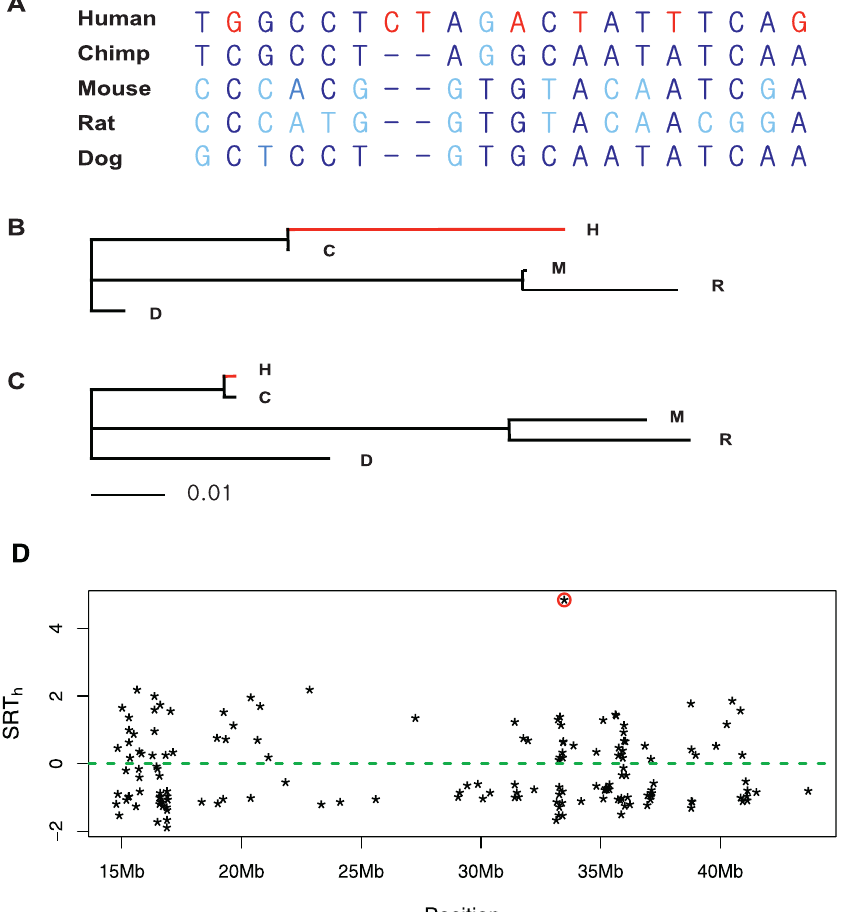
Figure 5. Example of a 144-bp CNC on Chromosome 21 (q22.11) with a Dramatic Accumulation of Changes on the Human Lineage (See Text) (A) Data at the 20 sites that are variable among these five species, with human-specific changes in red. (B) Estimated tree for this CNC. (C) Estimated neutral tree based on neighboring CNCs. The scale bar indicates the expected number of substitutions per site, per unit branch length. (D) SRT h values for amniotic CNCs located on human Chromosome 21. The red circle indicates the CNC illustrated above.